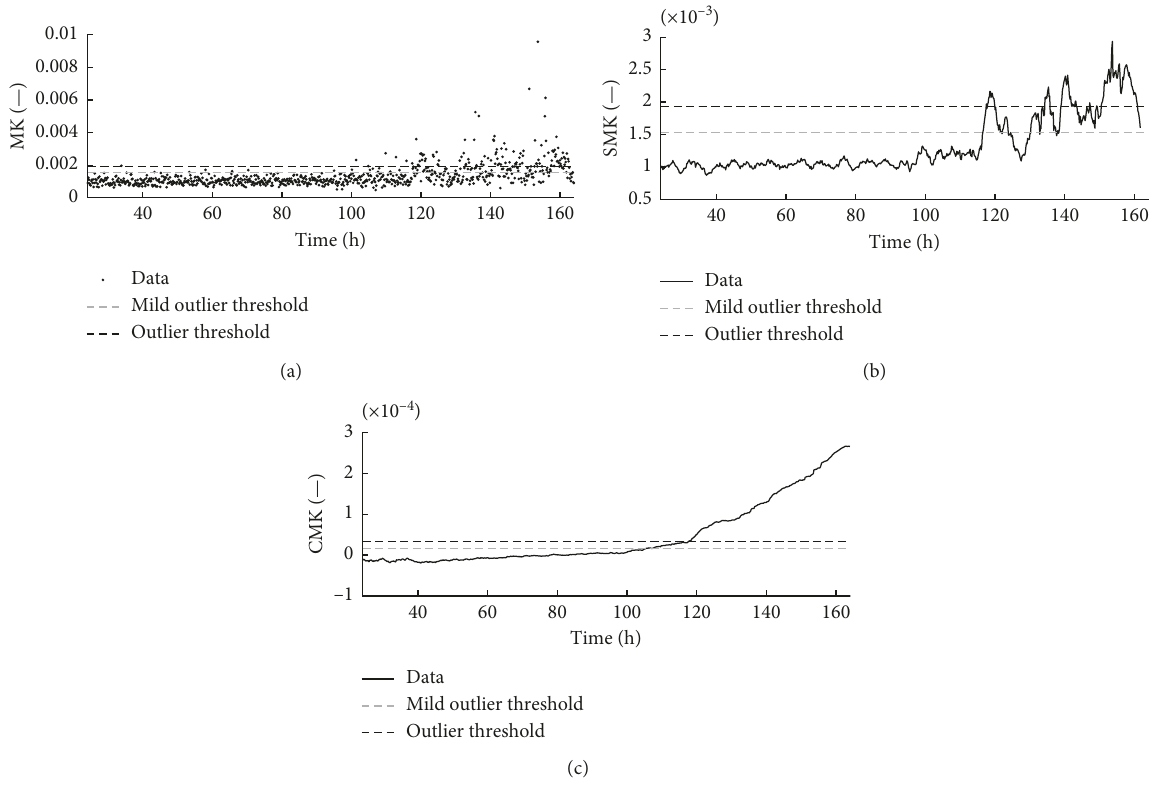
Figure 7: Application of the proposed method with MOMEDA: (a) MK values, (b) smoothed MK values (moving average), and (c) cumulative MK values. The considered prior period is referenced to the outer race bearing